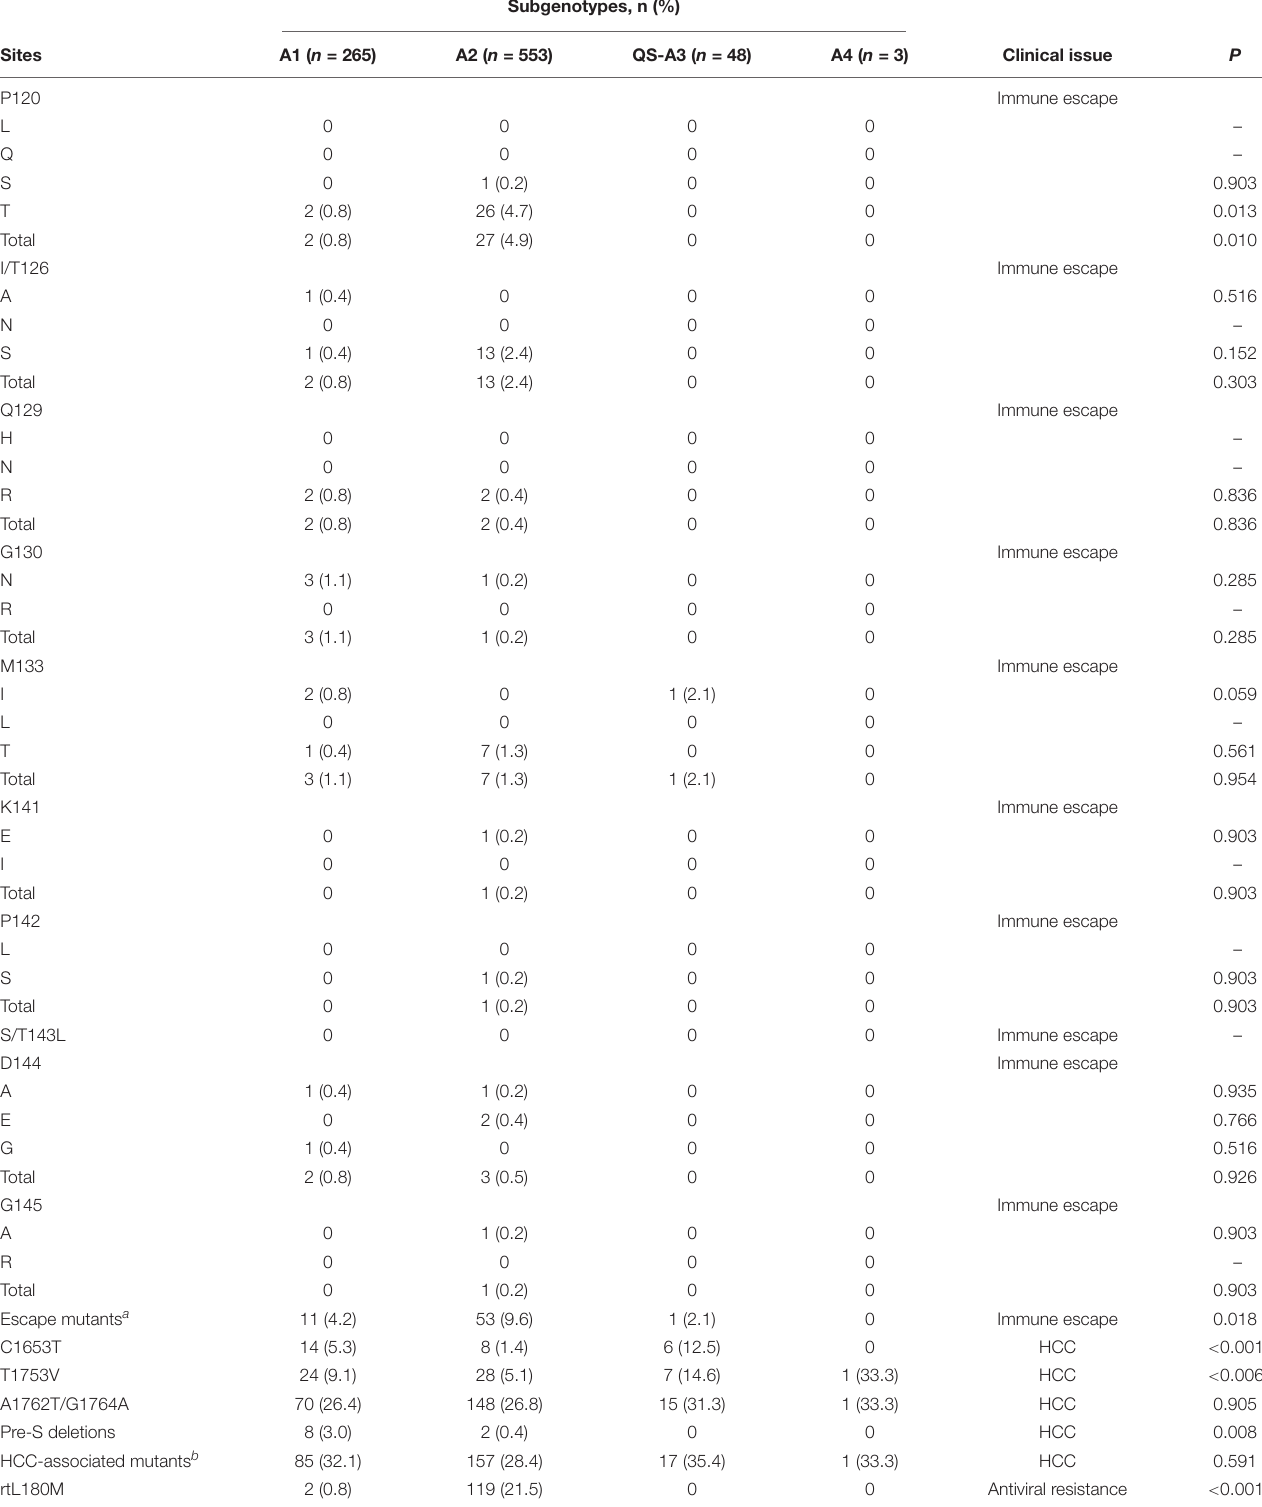
TABLE 2 | Clinically relevant mutations in HBV/A